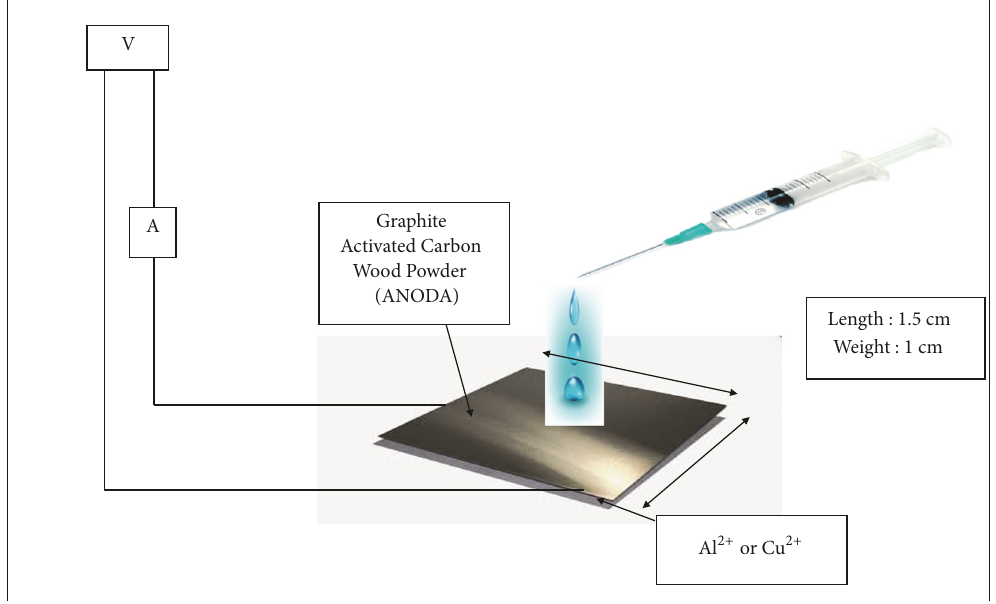
Figure 2: Method of response electricity